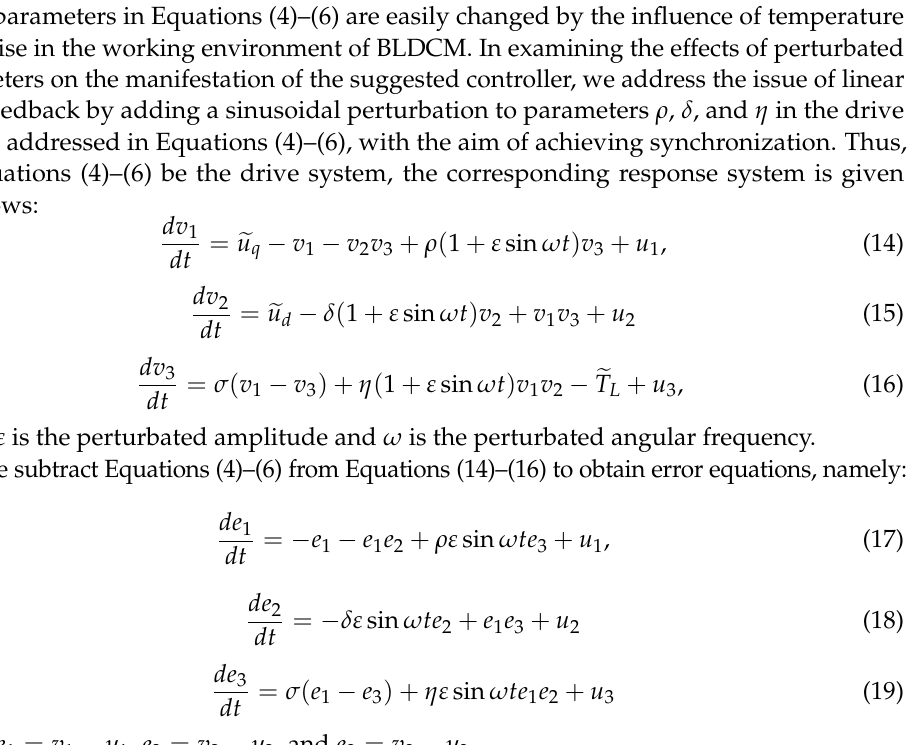
Figure 10. Converting chaos orbit to a period-1 motion for K = − 0.195 and σ = 4.26: ( a ) time history of angular speed. State-feedback control signal is adopted after 4 s, ( b ) controlled orbit.